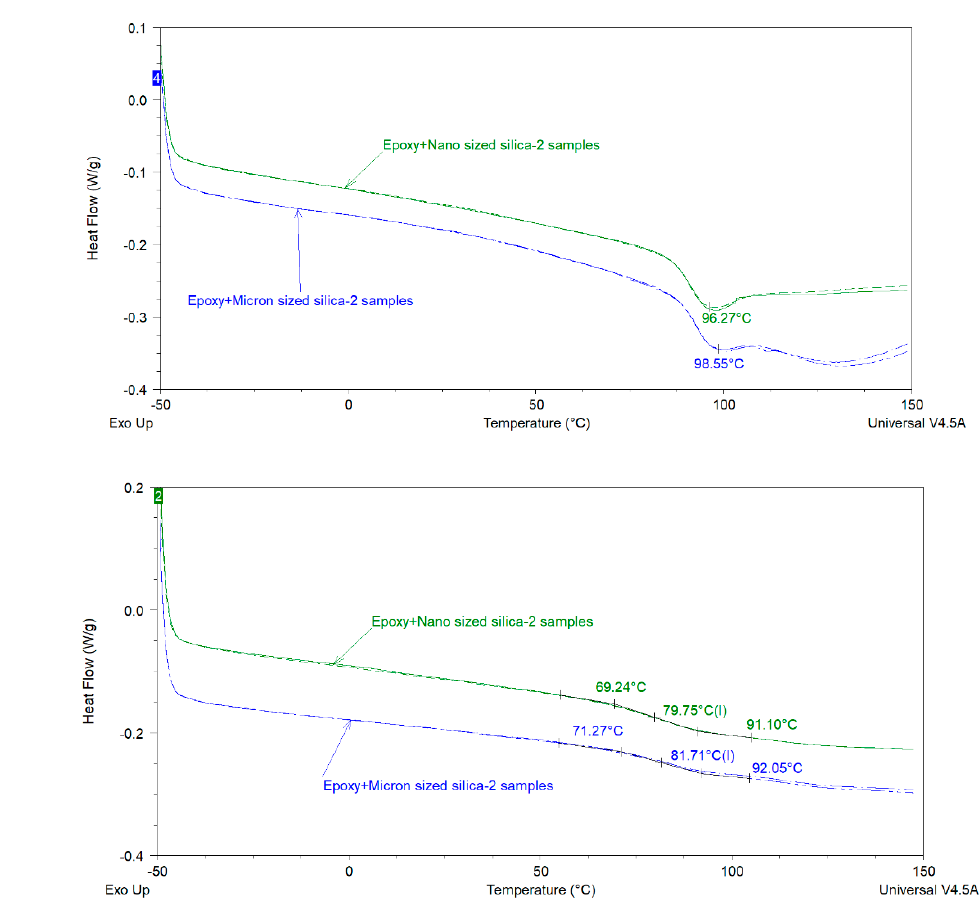
Figure 7. First heating ( a ) and Second heating scan ( b ) of epoxy coatings prepared with nanosilica and micrometer sized silica at the same Λ value of 0.51. Table 5. T g of the coatings estimated from 1st and 2nd DSC heating curves for samples with nanosilica and micrometer sized silica. N/A = not applicable.